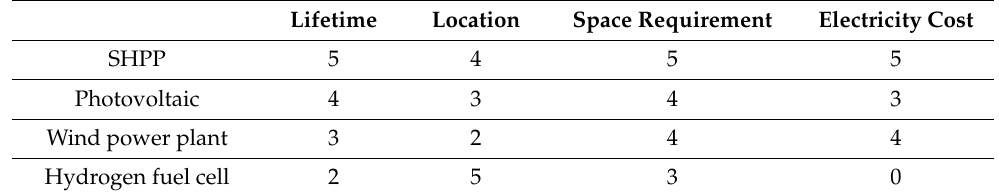
Table 4. Criteria values of the renewable power sources.